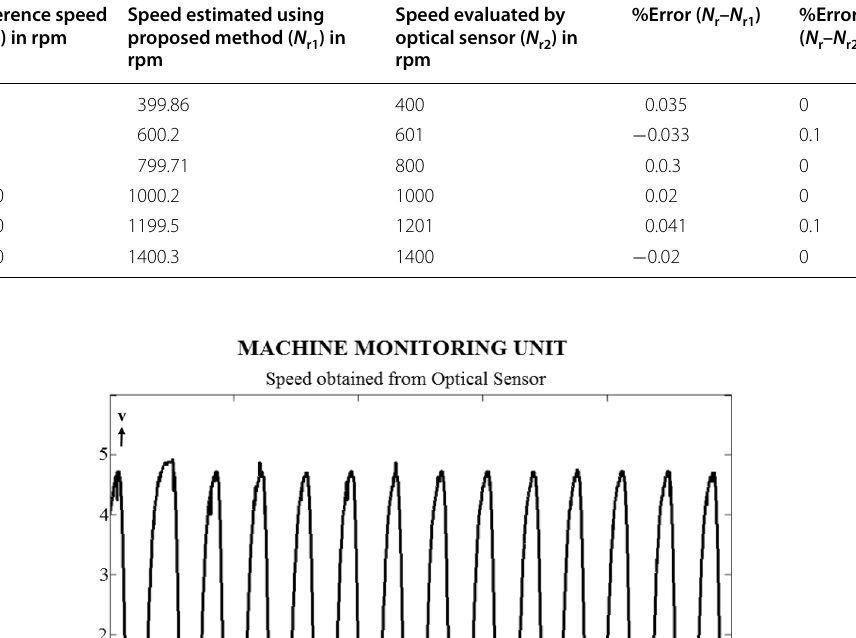
Table 6 Speed estimation by the proposed method Reference speed (Nr*) in rpm